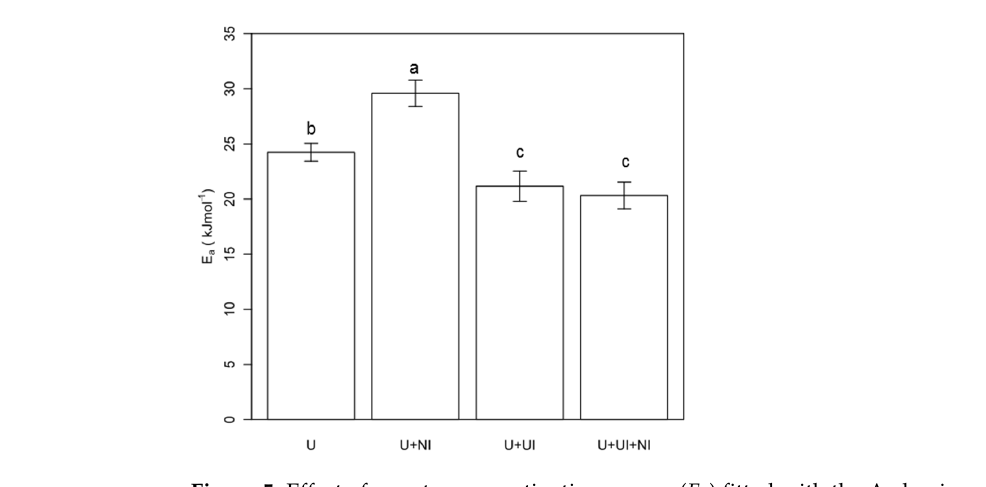
Figure 5. Effect of urea type on activation energy ( E a ) fitted with the Arrhenius equation. Error bars represent the standard error ( n = 4). Different letters denote statistical significance ( p < 0.05). The combination of Michaelis–Menten kinetics and the Van’t Hoff equation shows a close fit to the measured data (Table 3). Comparing with untreated urea (U), the urease inhibitor significantly decreased temperature sensitivity. Q 10 values derived from Van’t Hoff kinetic constants (Equation (8)) were 1.48, 1.69, 1.36, and 1.42 in U, U + NI, U + UI, and U + UI + NI, respectively (Table 3), and showed the same trend as those fitted with Equation (7). The RMSE varied from 0.76 to 3.46 mg NH 4+ ‐ N kg − 1 h − 1 , lower than those from Arrhenius equation fitting. Table 3. Regression with the combination of Michaelis–Menten and Van’t Hoff equation (Equation (5)). Estimates Fertilizer